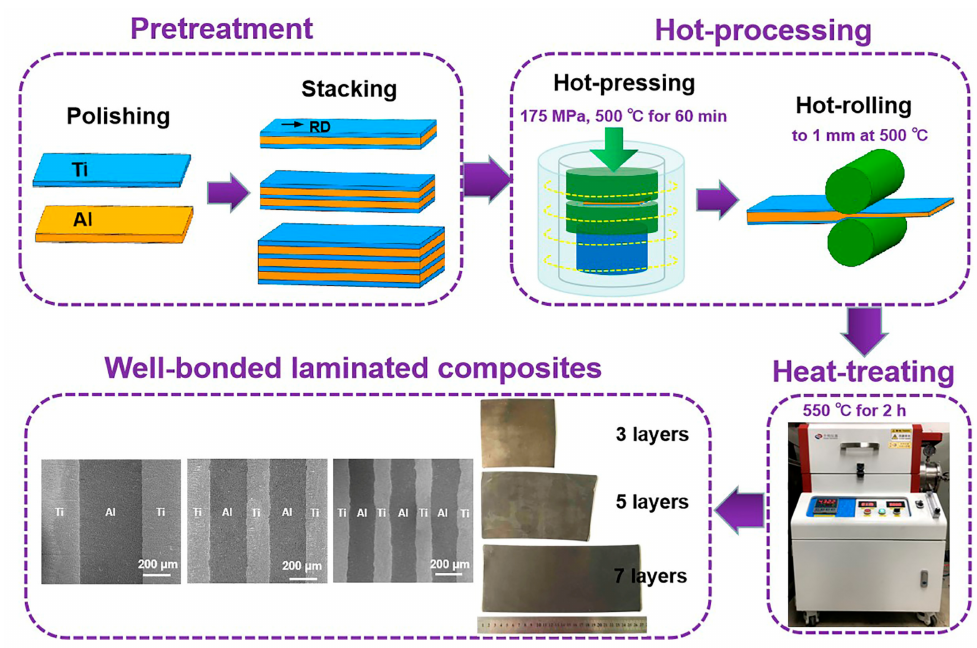
Figure 1. The schematics to fabricate Ti/Al multilayered composites by hot-pressing and